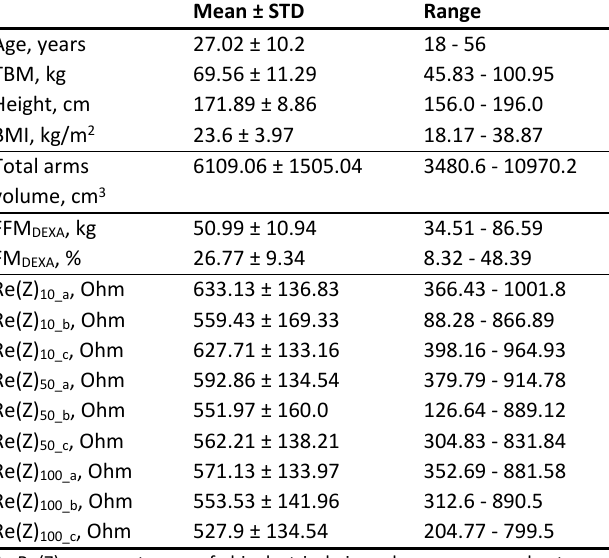
Table 1: Anthropometric, body composition and bioelectrical impedance